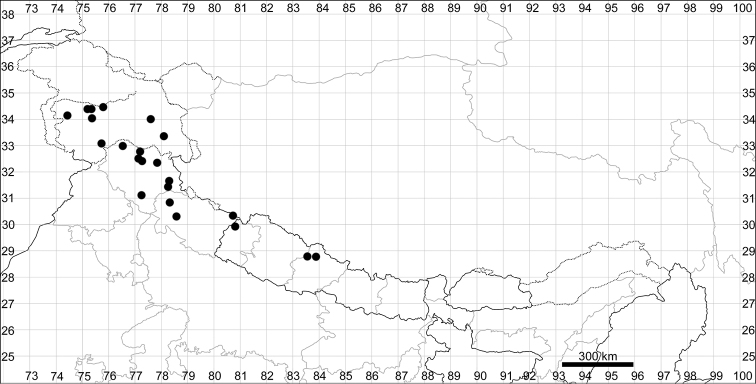
Distribution map of Blitumvirgatum.